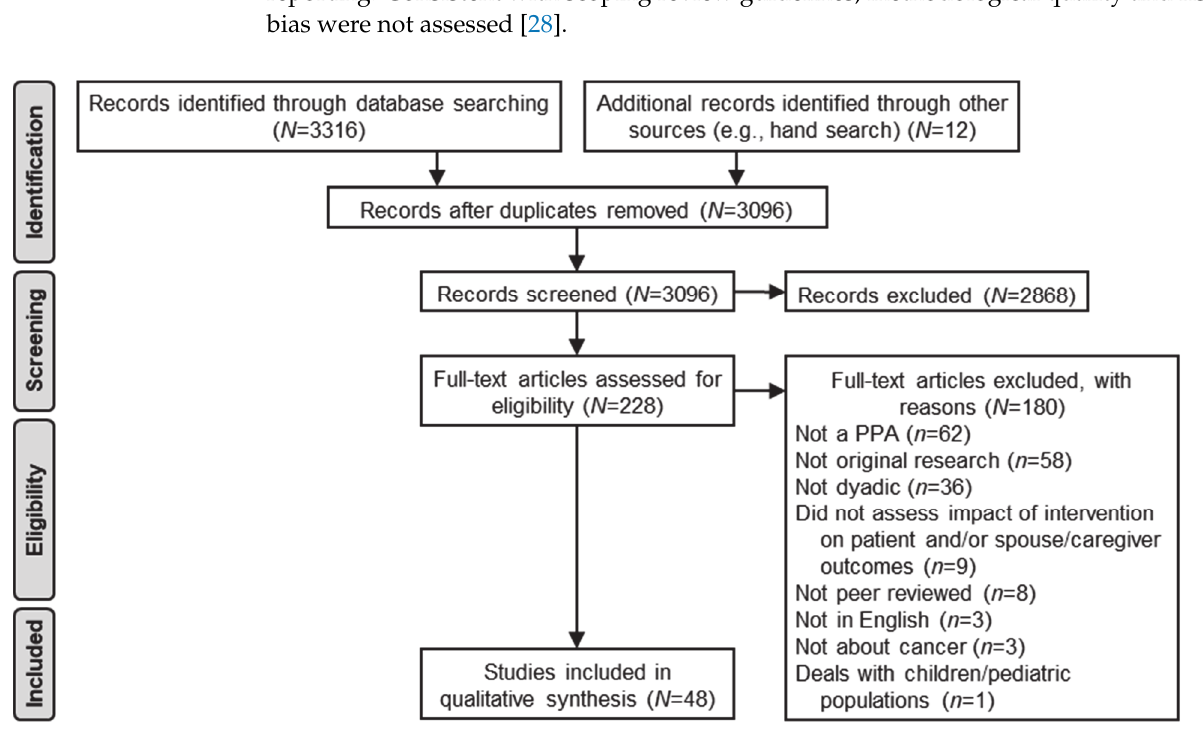
Figure 1. PRISMA Flow Diagram.